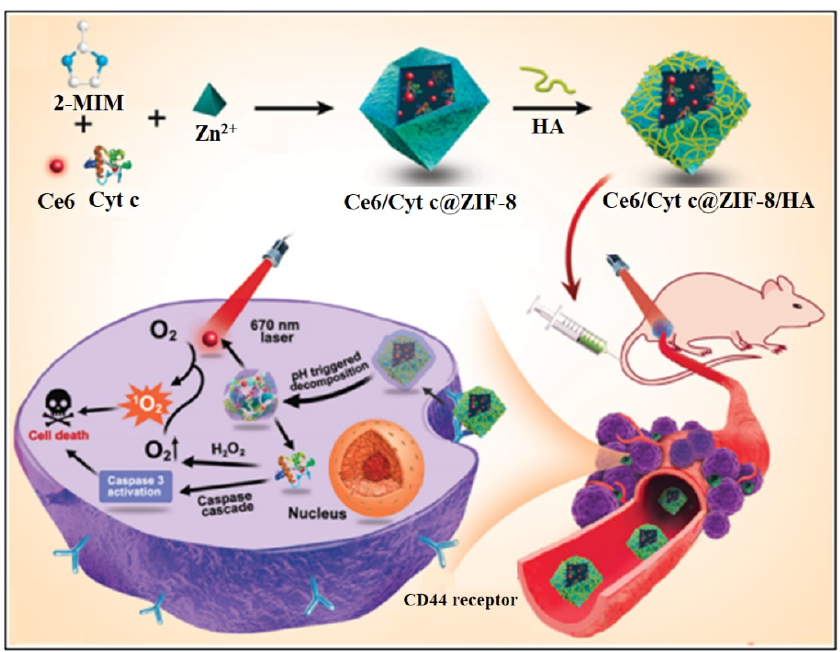
Figure 13. Examples of Light-responsive chemically modified BioMOF nanostructures: Ce6/Cyt c @ZIF-8/HA NPs. Reproduced with permission from Ref. [207]. Copyright © 2020, American Chemical Society.